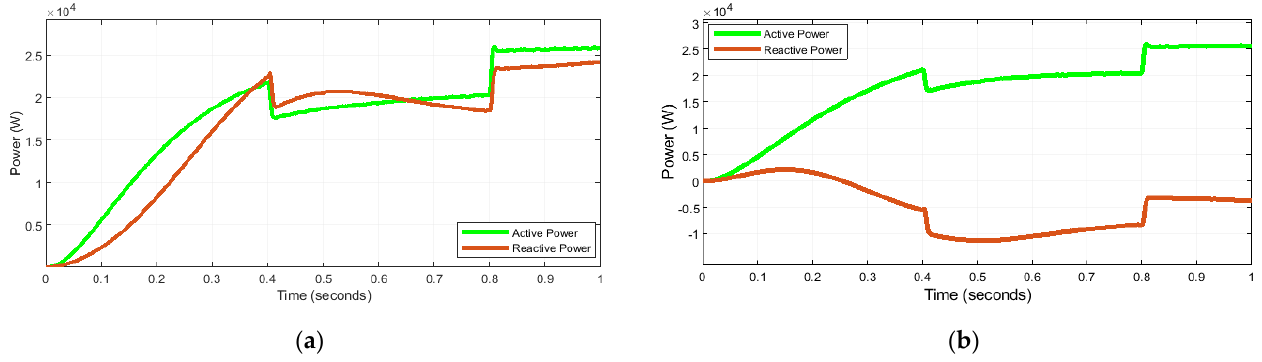
Figure 8. When the parameters change slightly, the output of active and reactive power: ( a ) DG1;